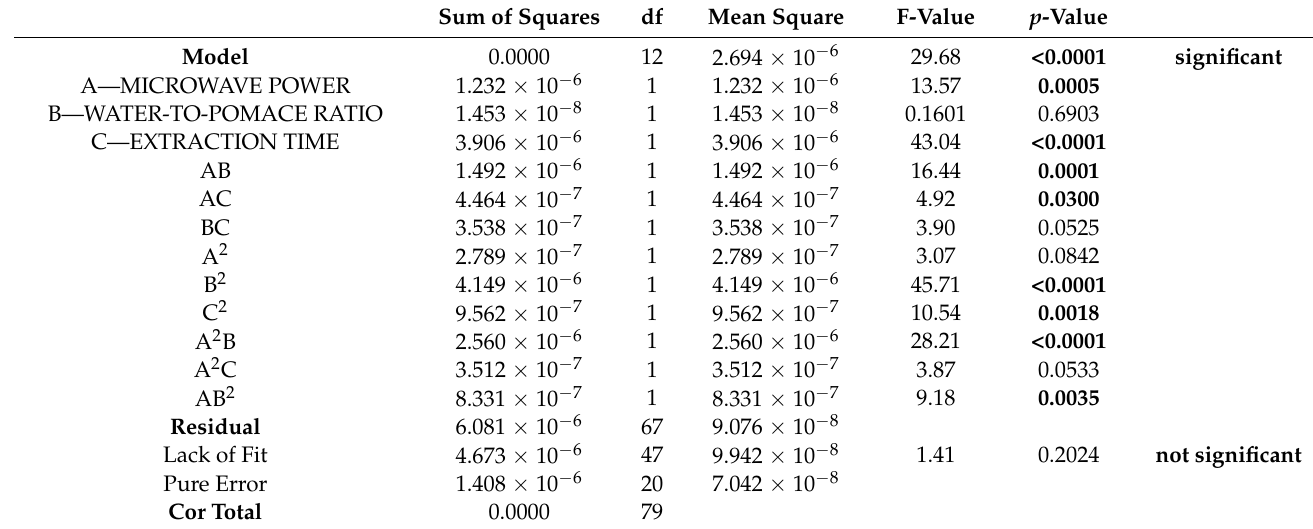
Table 2. Analysis of Variance (ANOVA) of the derived model for prediction of the amount of the total polyphenols in OP extracts.